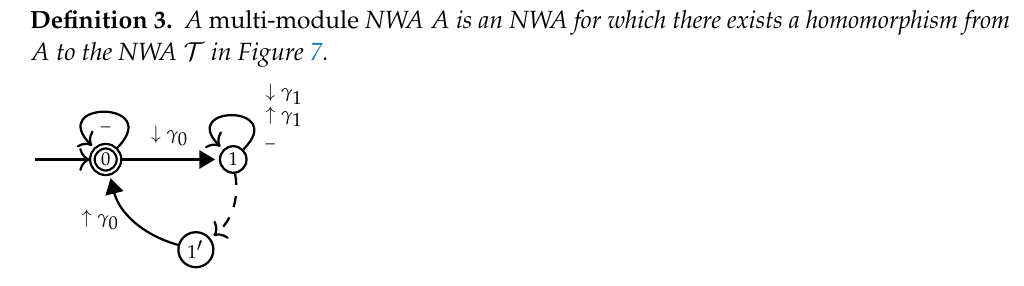
maps top level positions to state 0 and nested positions to 1 or 1 (cid:48) . Figure 7. The NWA T The NWA evaluates all top level positions of a nested word to state 0: all those T positions that are not between parentheses. All nested positions are evaluated to state